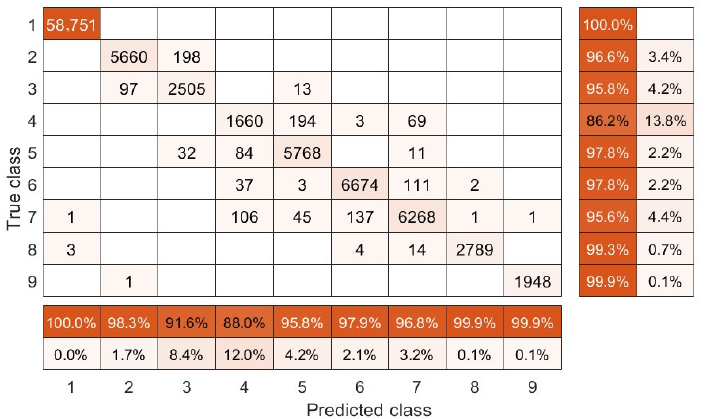
Figure 7. The confusion matrix of the developed model on the Center of Pavia dataset.